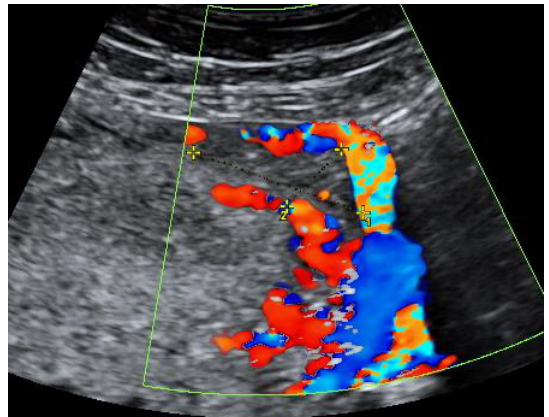
Figure 7. Left cornu of the uterus visualized by transabdominal ultrasonography 1 day postpartum.